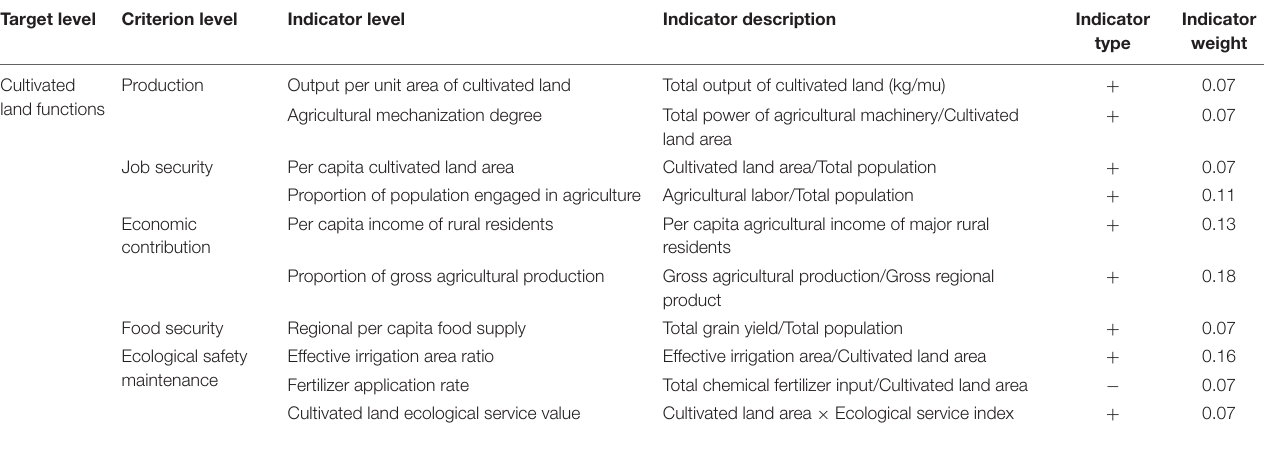
TABLE 1 | Evaluation indicator system for functions of cultivated land system in Henan